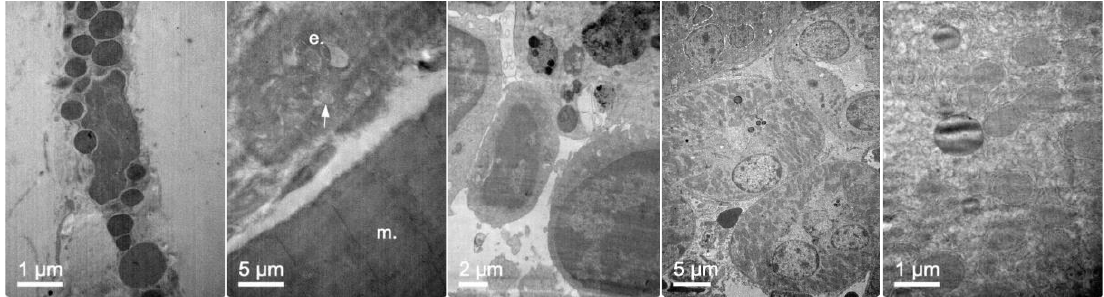
Figure 17. TEM images of ( left to right ) fibroblasts, vascular endothelia between muscle fibers, spleen macrophages, renal tubular cells, and hepatocytes of mice 24 h after administration of elosulfase alpha-NLC.